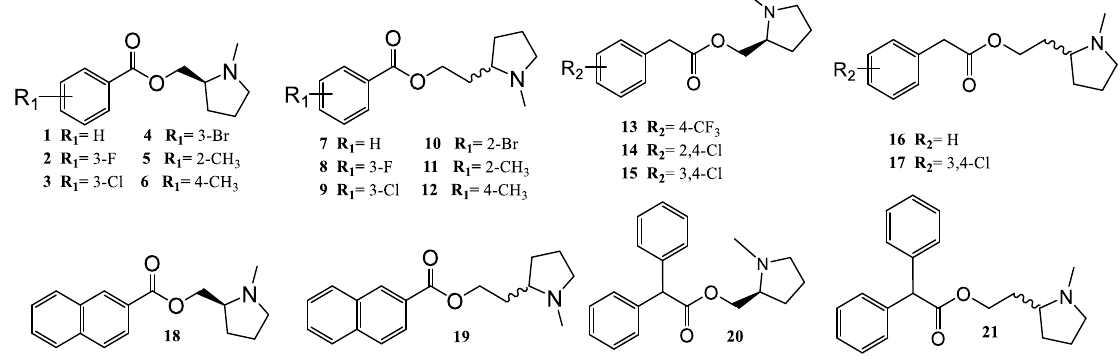
Figure 3. Structures of the 21 synthesized compounds used in this study.